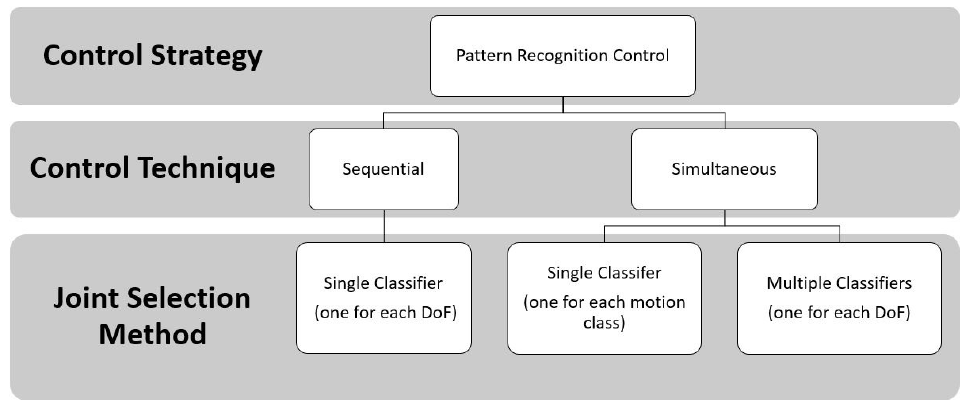
Figure 9. Schematic diagram of pattern recognition-based myoelectric control techniques and joint selection